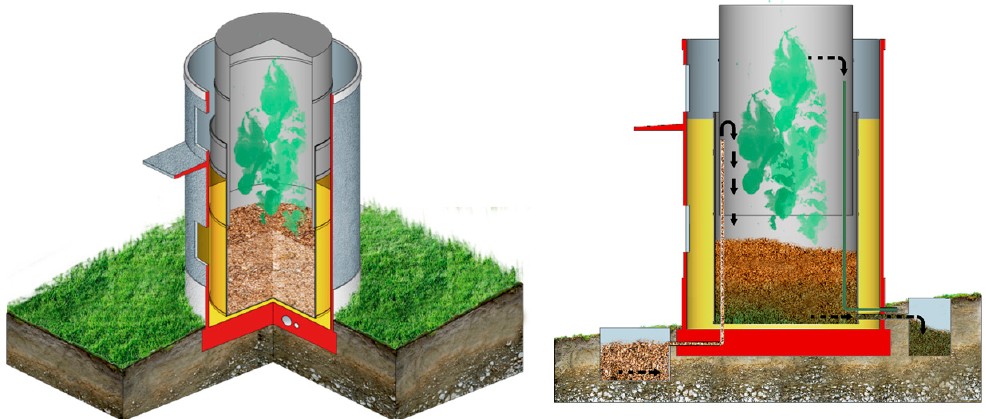
Figure 5. An overview of the small-scale biogas plant integrated within the silo.